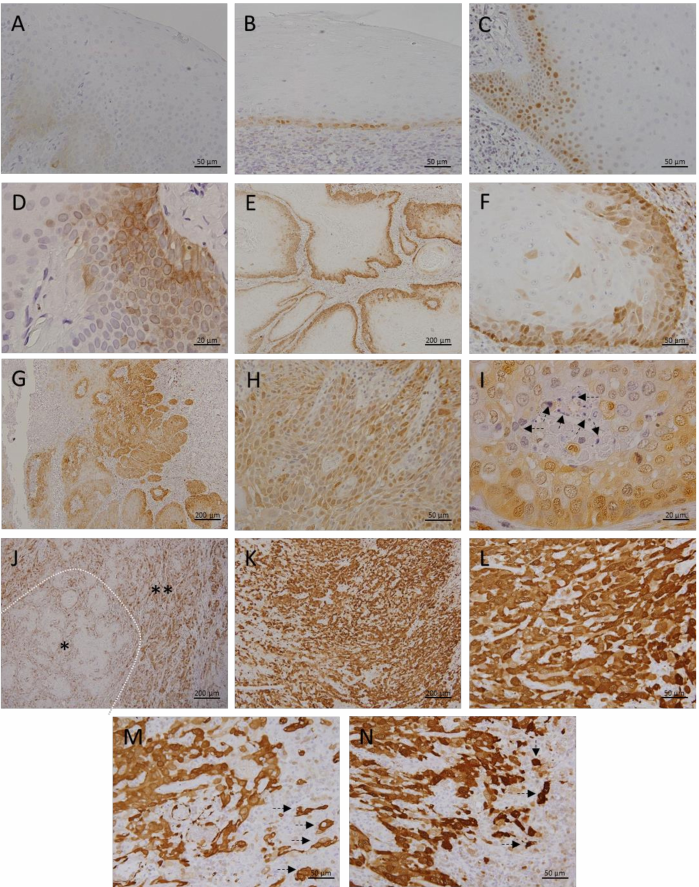
Figure 1. Metallothionein I/II expression in premalignant and malignant oral squamous epithelial lesions. Representative photomicrographs show immunohistochemical staining with anti-MT I/II antibody on paraffin-embedded sections of tissue samples obtained from subjects with healthy oral mucosa ( A ), patients with oral lichen planus ( B ), oral leukoplakia ( C , D ), grade I OSCC ( E , F ), grade II OSCC ( G – I ), mixed-grade (I/II) OSCC ( J ), and grade III OSCC ( K – N ). Arrows on I indicate pyknotic nuclei and apoptotic bodies in areas lacking MT I/II immunopositivity. Asterisks on J mark grade I (*) and grade II (**) cancer tissue in mixed-grade tumor. Arrows on M and N point to MT I/II immunopositive cancer cells infiltrating adjacent non-immunopositive healthy tissue at tumor edges. Magnifications: ( E , G , J , K ) × 100; ( A – C , F , H , L , M , N ) × 400; ( D , I ) ×